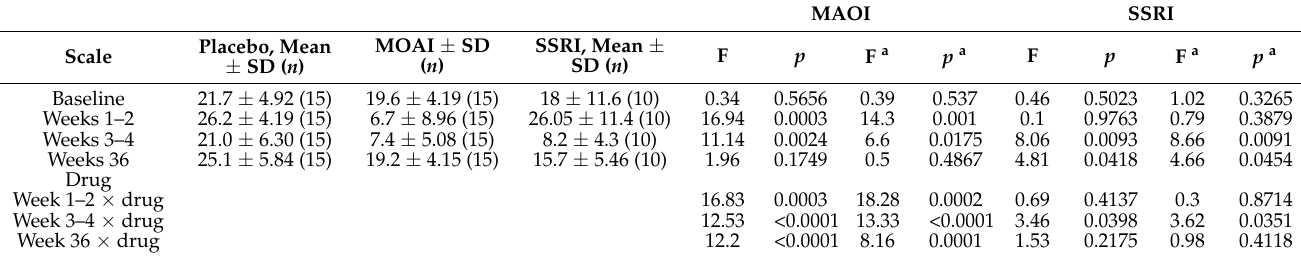
Table 2. Changes in consumption amount (averaged mL/per week) of area nut water after antidepressants treatment in mouse mode (follow-up 4 and 36 weeks).